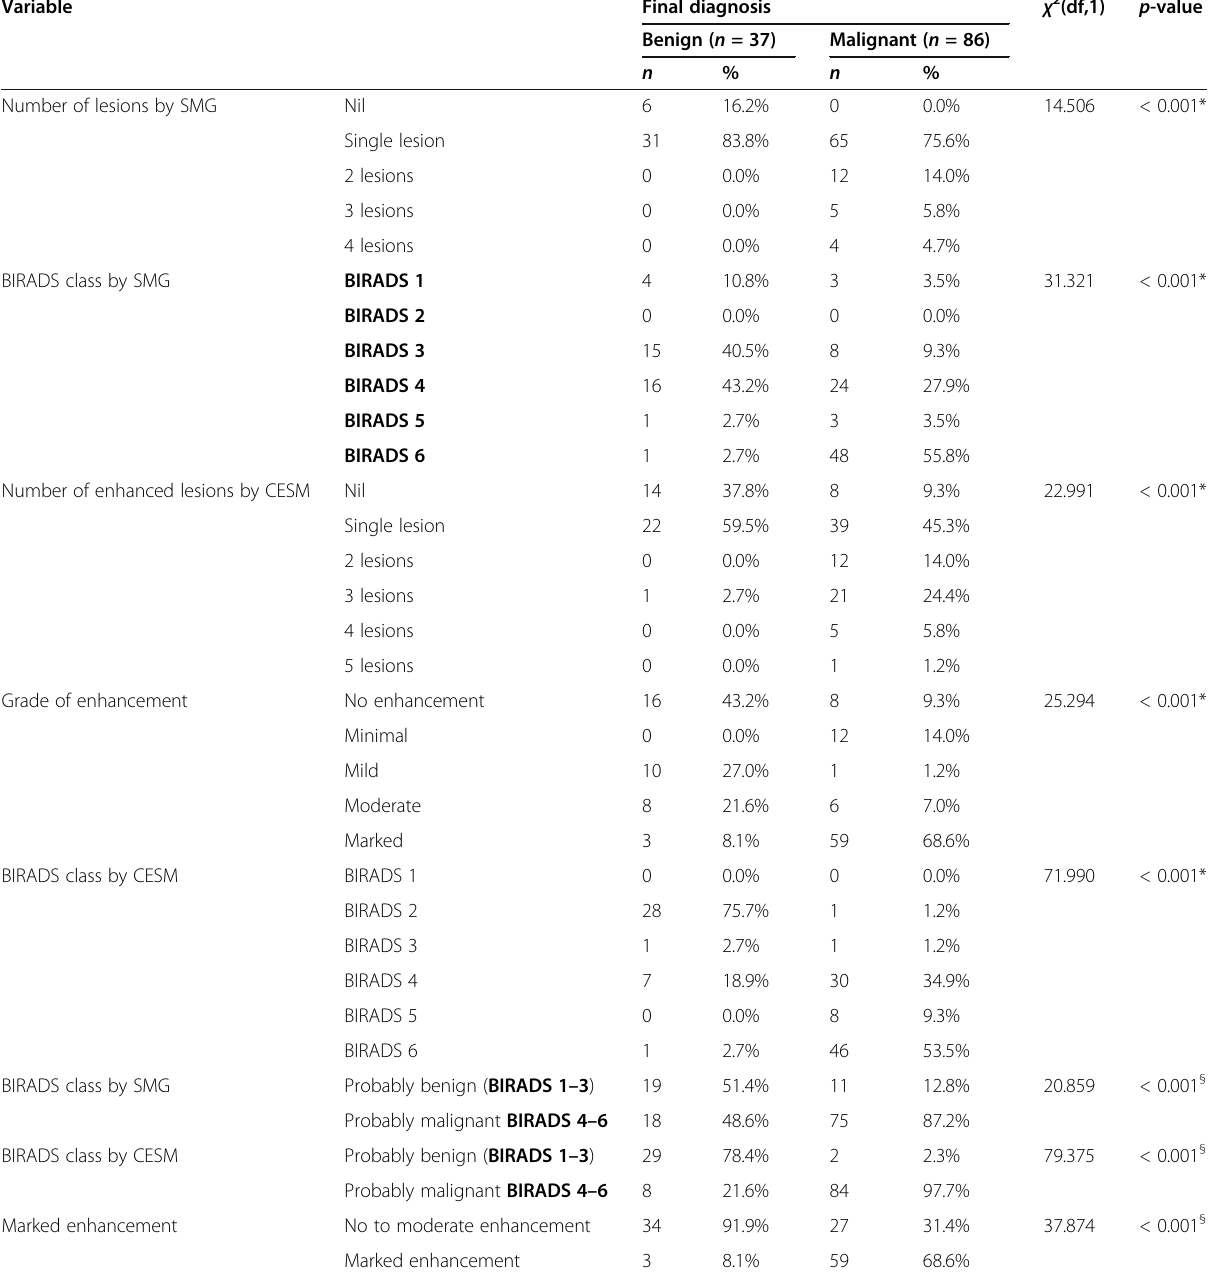
Table 3 Radiological characteristics of benign or malignant lesions Variable Final diagnosis χ 2 (df,1)